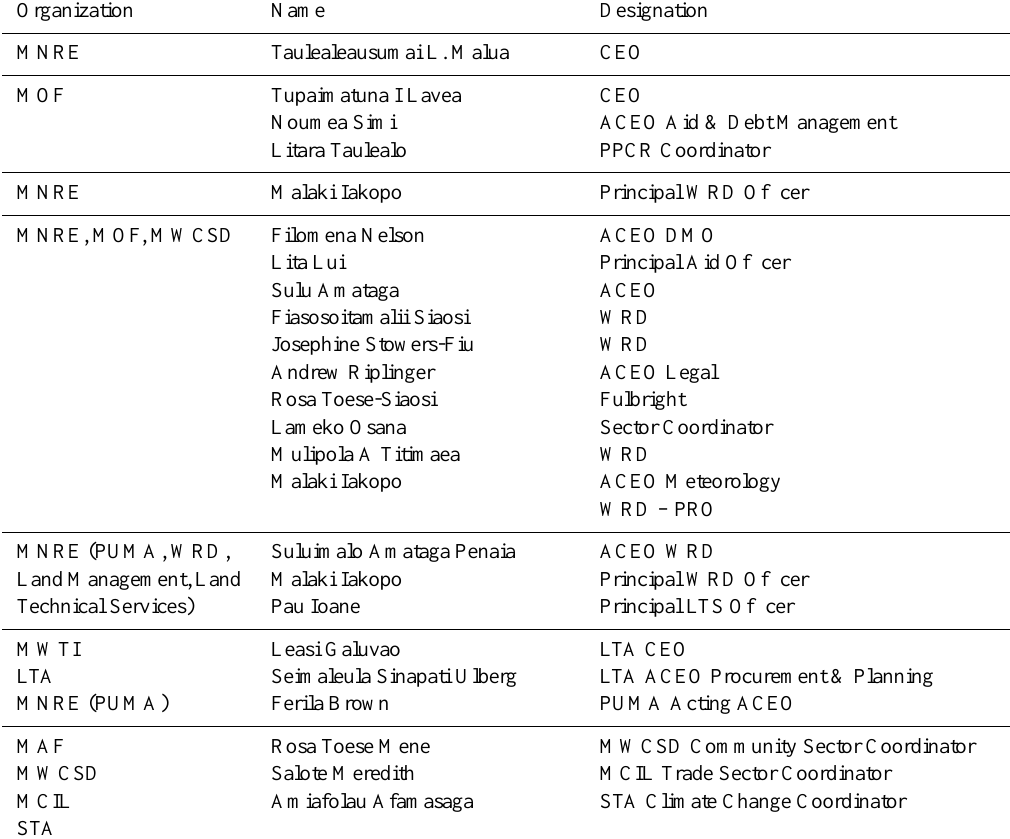
Table A1. List of stakeholders